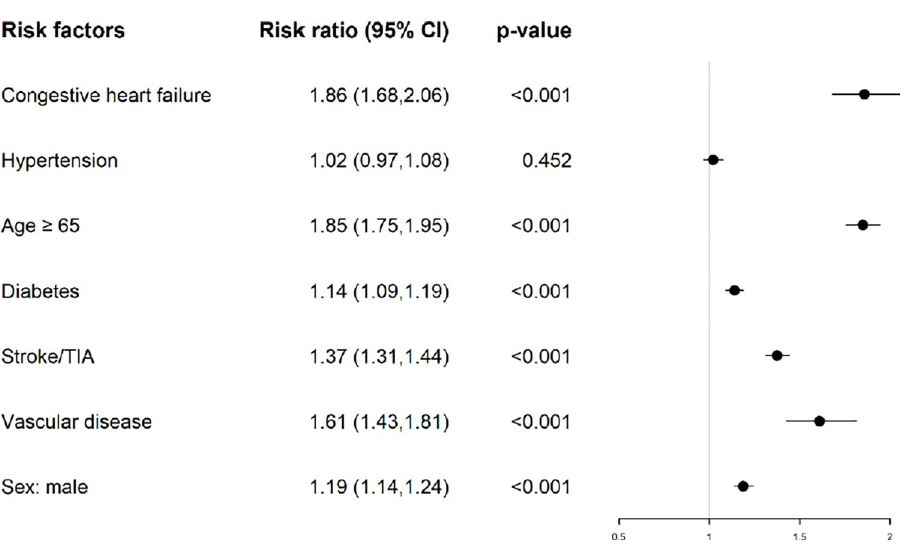
Fig 3. 1 year MACCE associated with individual risk factor of CHA2DS2-VASc